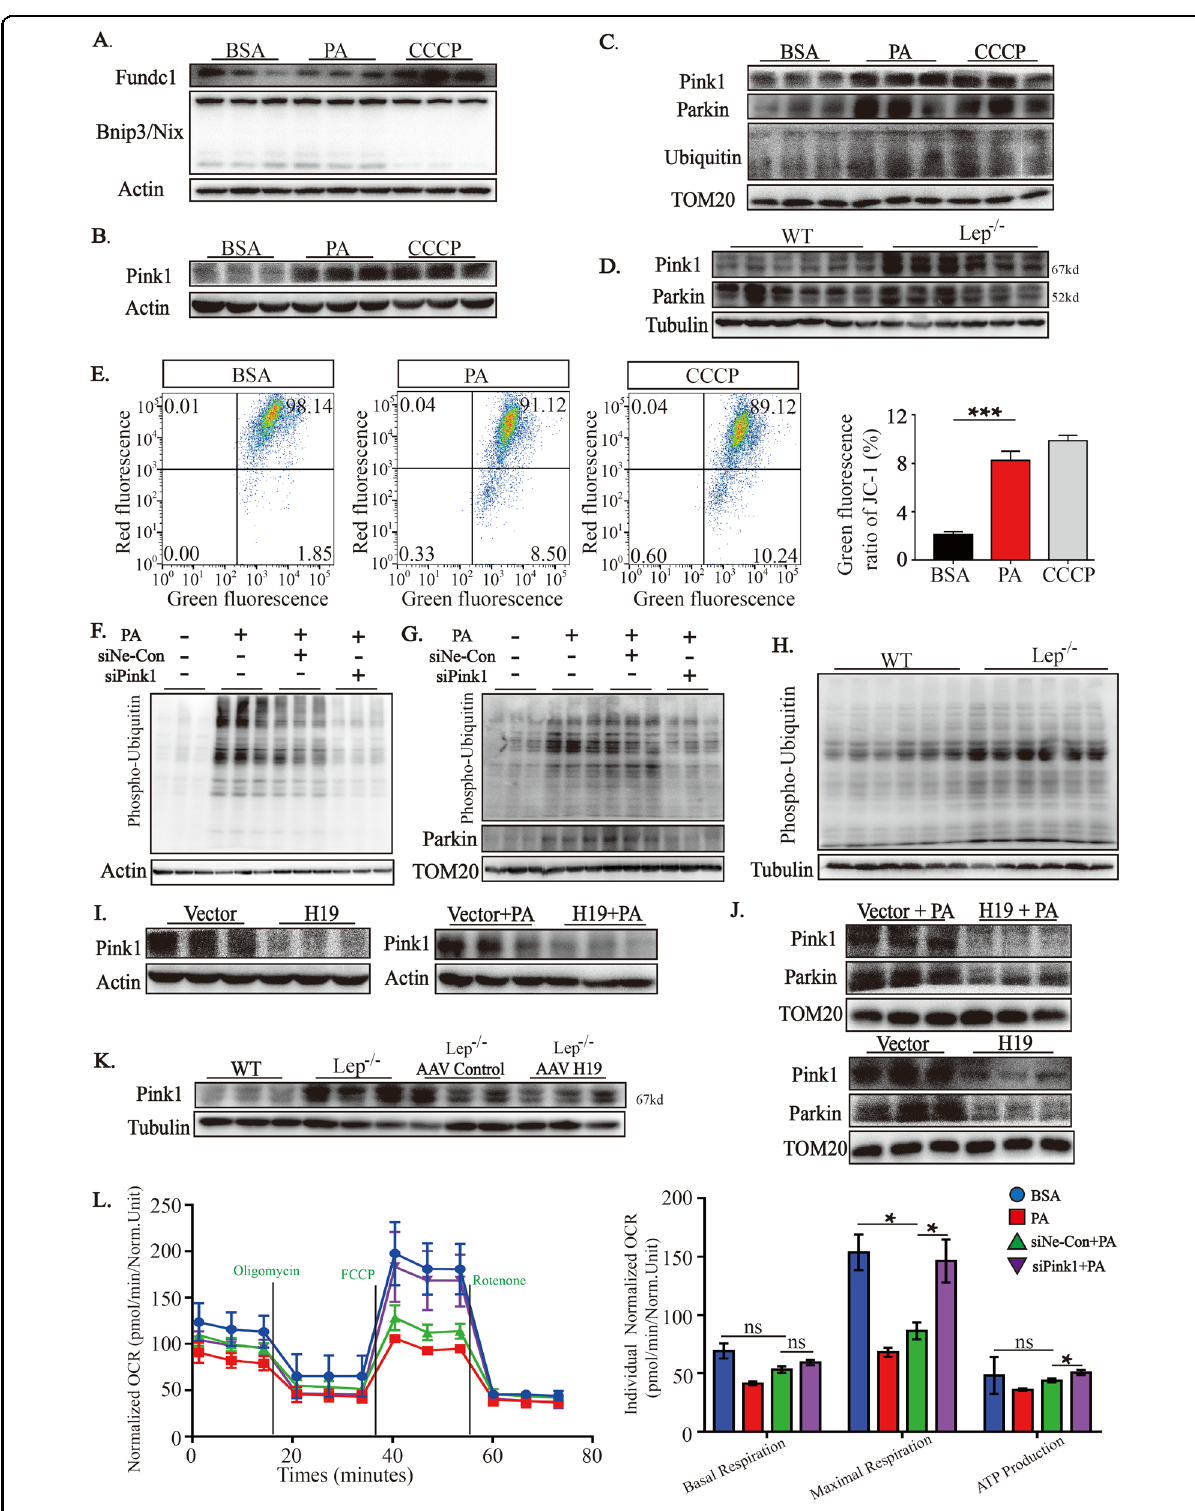
Fig. 4 (See legend on next